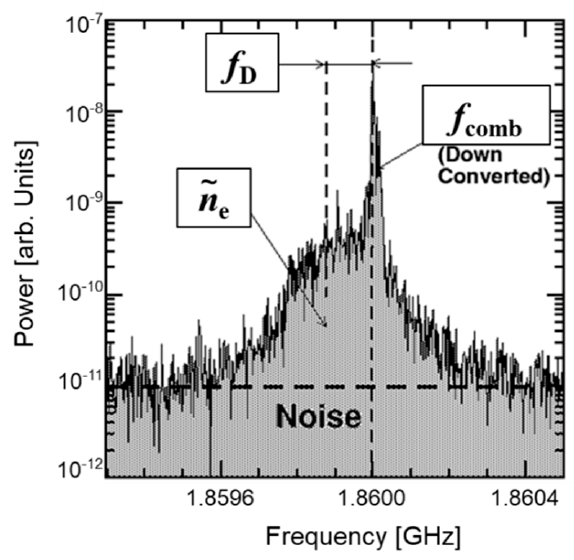
Figure 3. Example of Doppler shift frequency spectrum obtained by reflectometer in LHD. Here, f comb = 1.86 GHz is IF frequency down-converted from carrier wave and f D is estimated Doppler shift frequency.